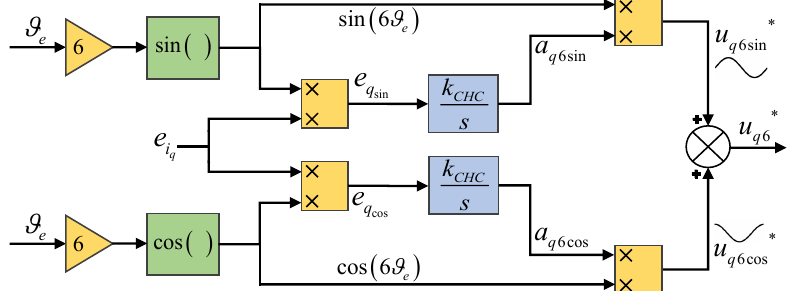
Figure 13. Current harmonic controller for calculation of compensation q -axis voltage.